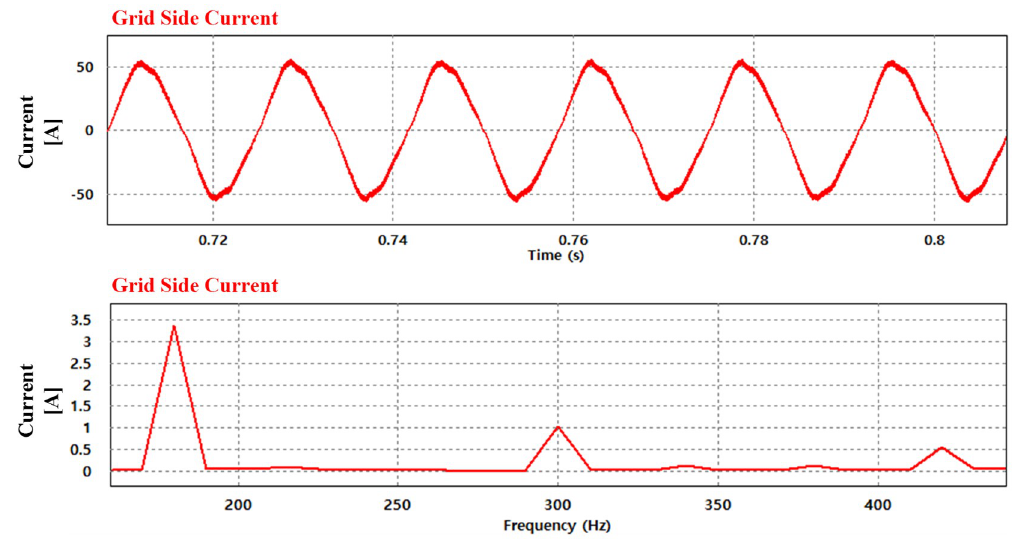
Figure 10. Simulation results without applying lower-order harmonics compensation method.